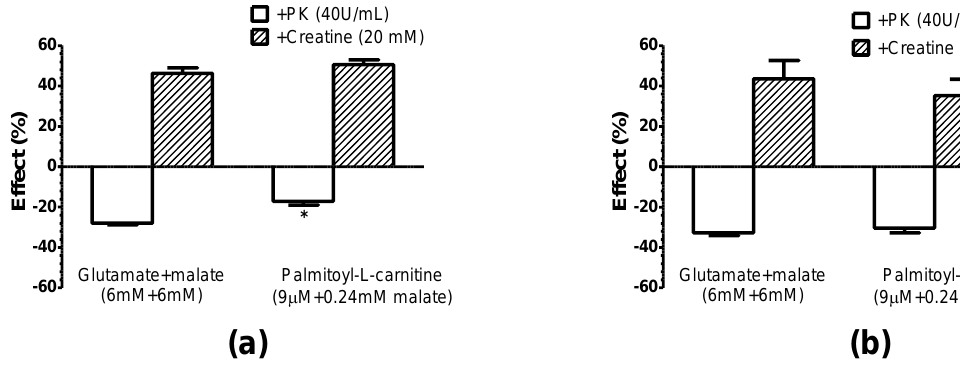
Figure 9. Influence of pyruvate kinase + phosphoenolpyruvate (PK + PEP) ADP-consuming system and creatine on the respiration of rat cardiac fibers using glutamate + malate and palmitoyl- l -carnitine + malate as respiratory substrates at ( a ) 25 ◦ C and ( b ) 37 ◦ C. The e ff ect of pyruvate kinase (PK) (40 U / mL) on V ATP and the e ff ect of creatine on V PK (40 U / mL) are shown. * p < 0.05 versus 37 ◦ C with palmitoyl- l -carnitine, n = 5 (paired experiments). The results were analyzed with one-way analysis of variance (ANOVA) followed by Tukey’s multiple comparison test.